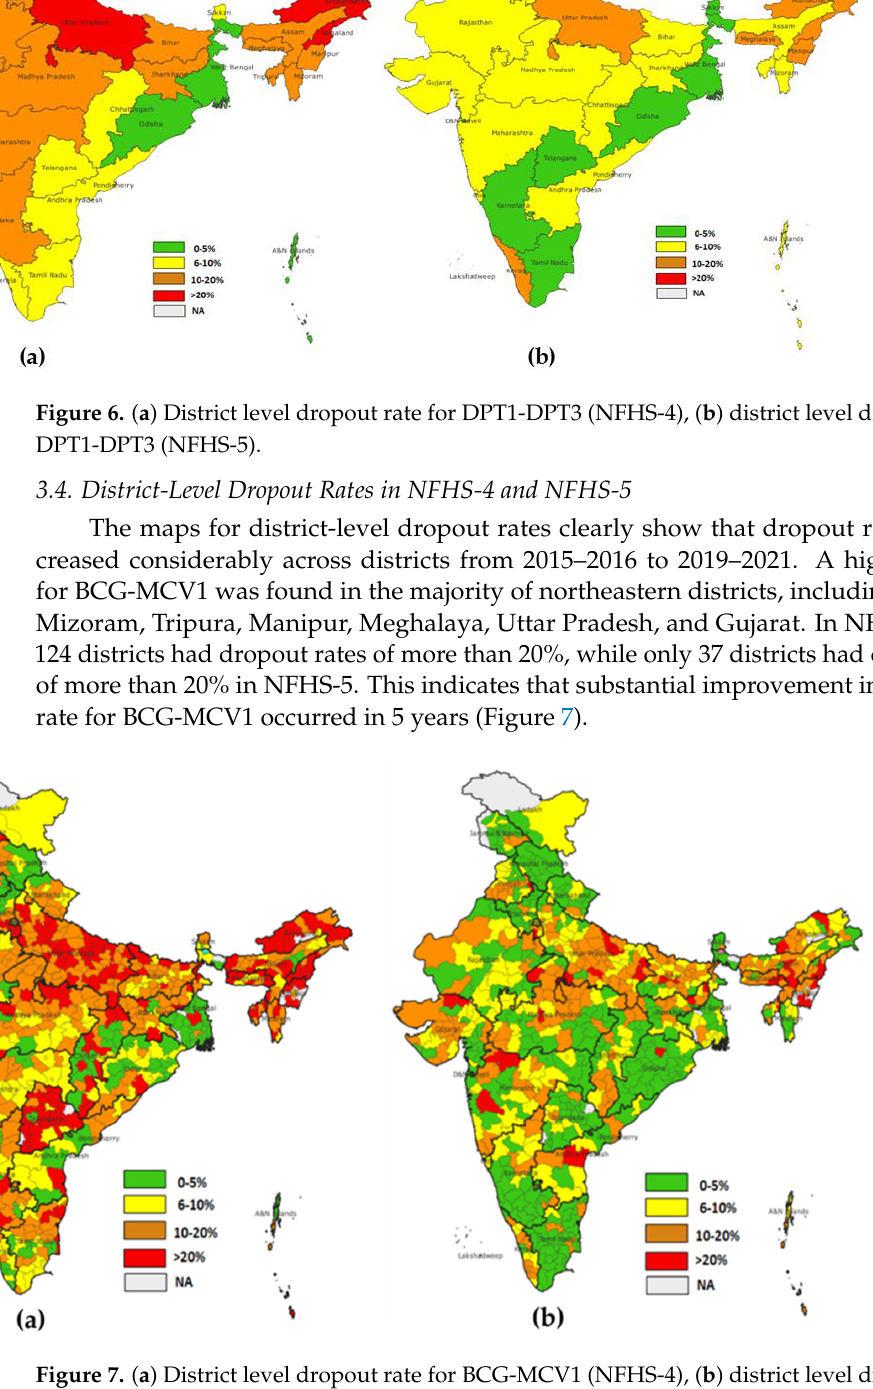
Figure 5. ( a ) State level dropout rate for OPV1-OPV3 (NFHS-4), ( b ) state level dropout rate for OPV1-OPV3 (NFHS-5).